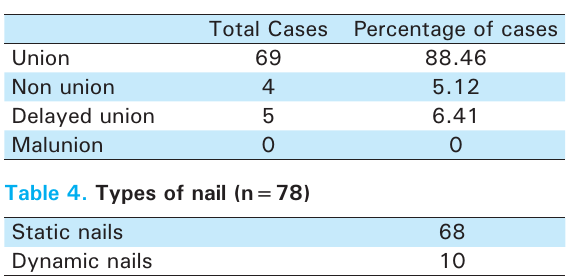
Table 5. Out come of results of interlocking